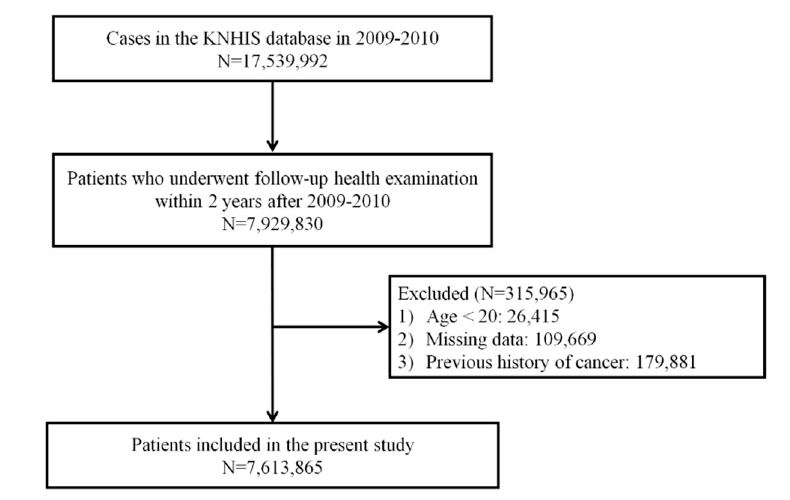
Figure 1. Flow diagram showing the study design.